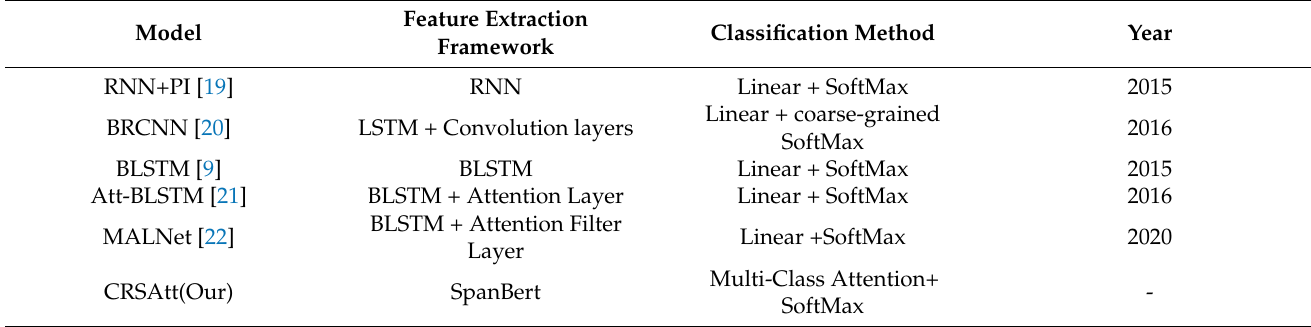
Table 2. Summary of our model and the recurrent-neural-network-based models.